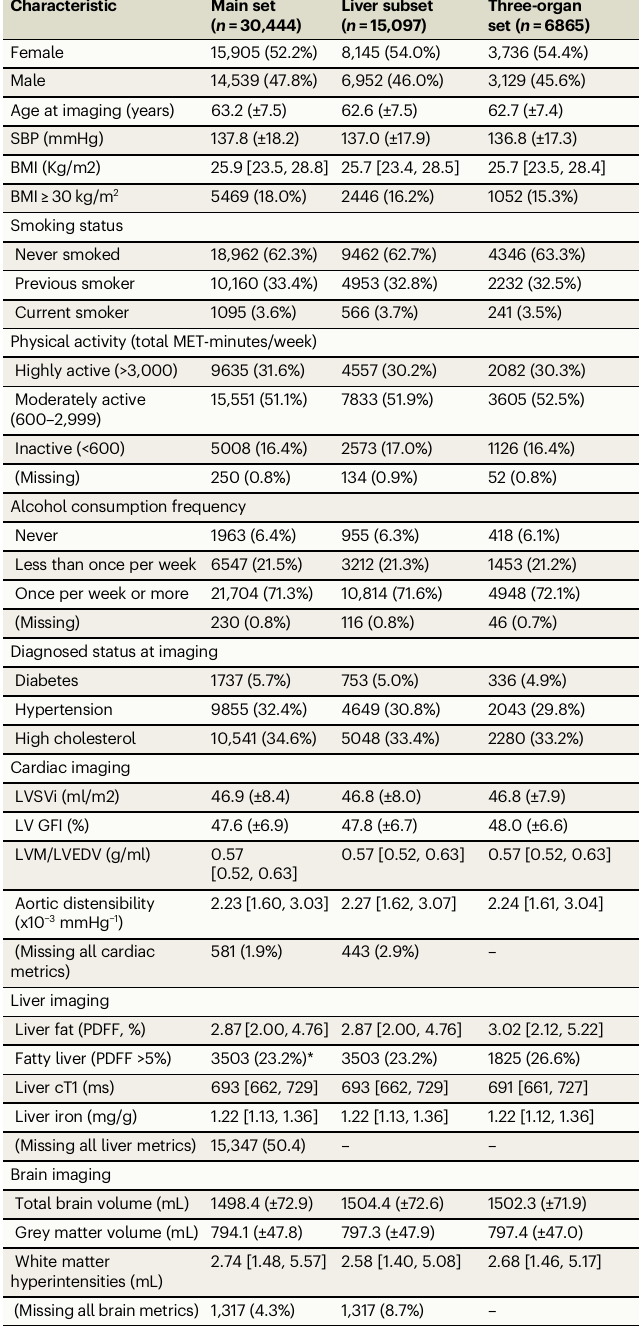
across all three organs has 6,865 participants. This is the set that was used for the three-organ path